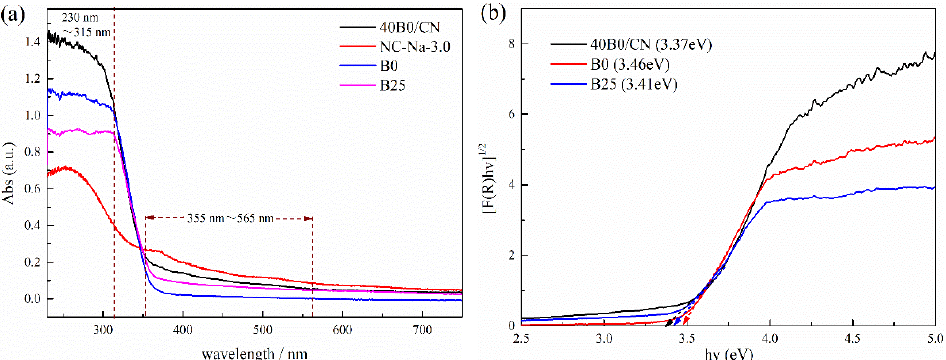
Figure 3. UV ‐ Vis DRS ( a ) and band gaps ( b ) of different samples. Figure 3. UV-Vis DRS ( a ) and band gaps ( b ) of different